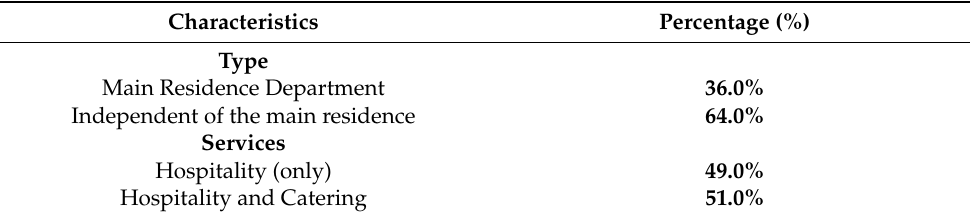
Table 5. Type and Services of tourism